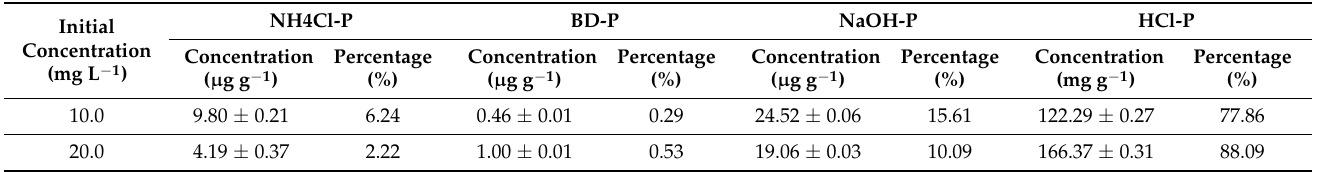
Table 5. Phosphorus fractionation after adsorbed by La-CZ.